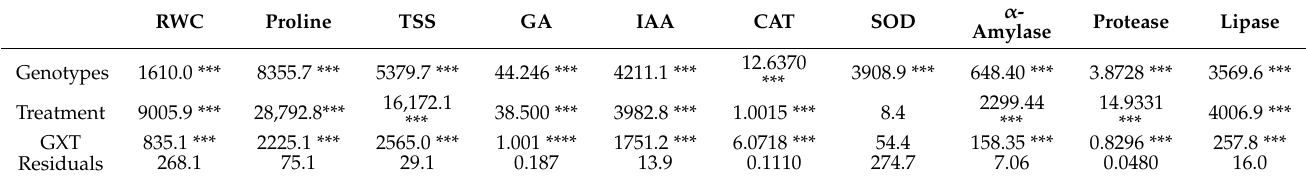
Table 3. Mean square of ANOVA analysis for morpho-physiological and metabolic parameters in the germinated seeds.